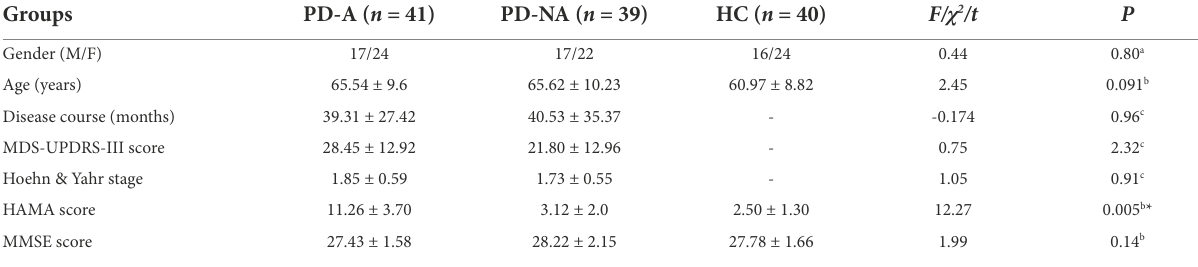
TABLE 1 Demographic and clinical